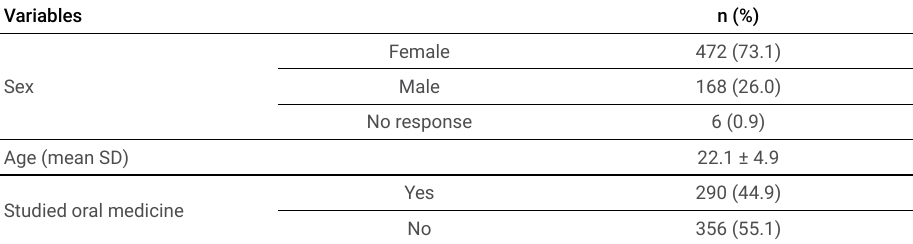
Table 1. Demographics of the study population (N= 646; Paraná,